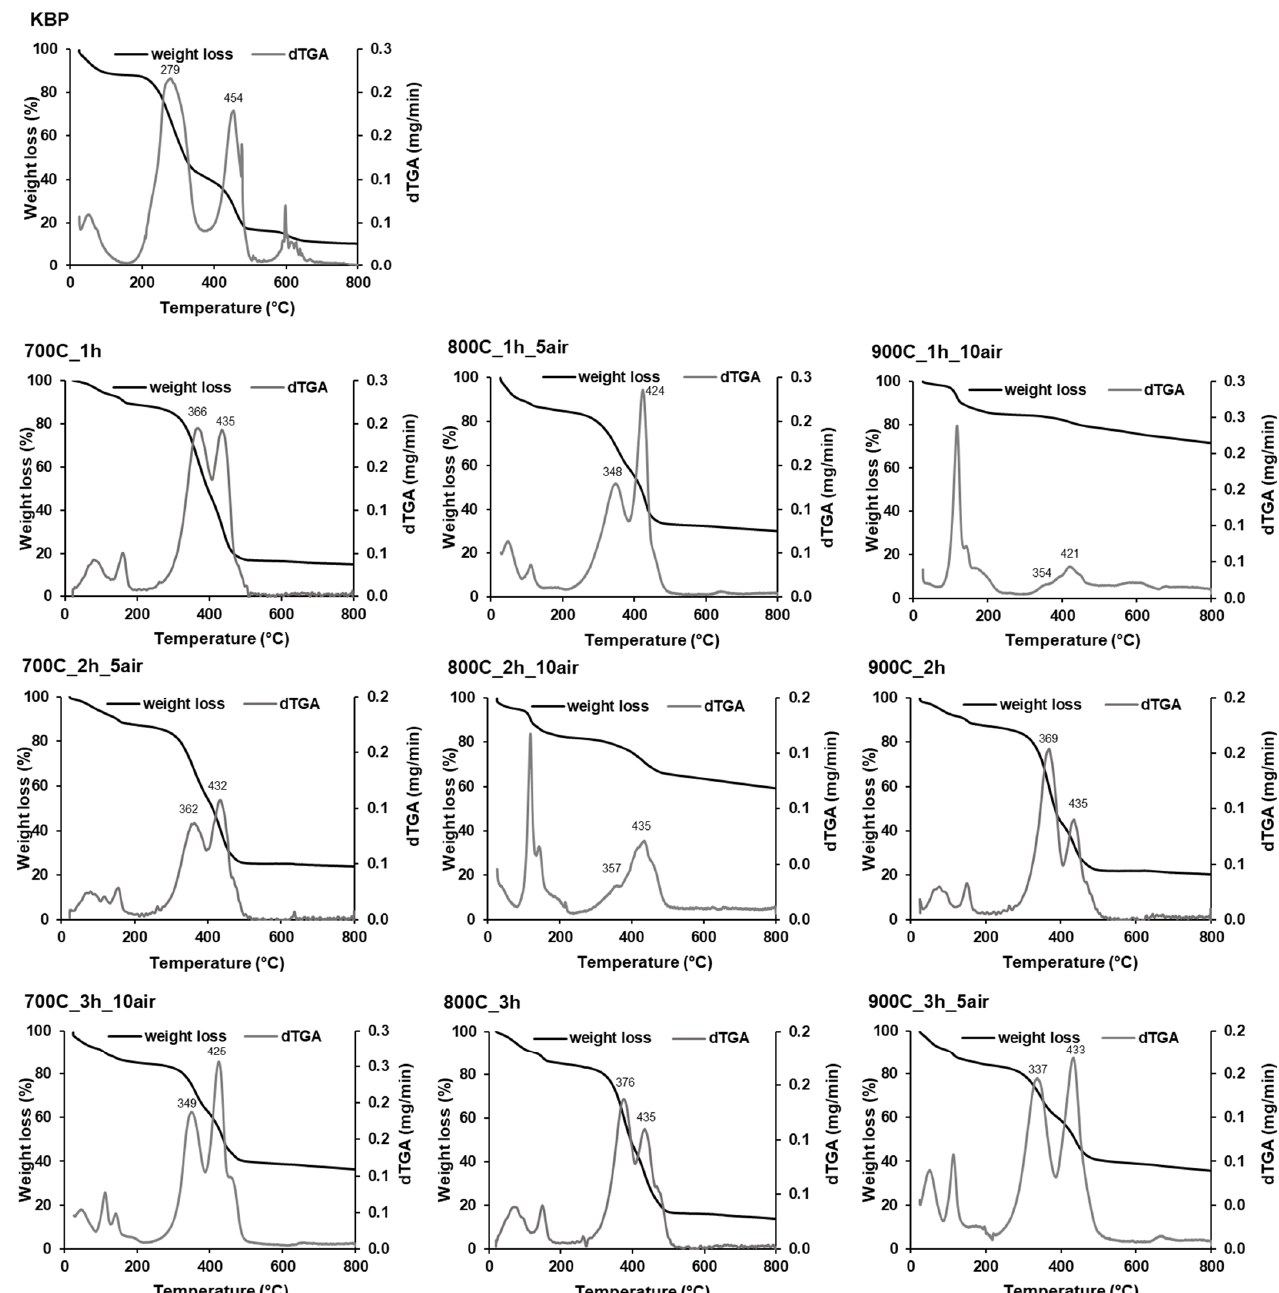
Figure 3. TGA/dTGA analysis of biomass (KBP) and biochars resulting from different pyrolysis con-